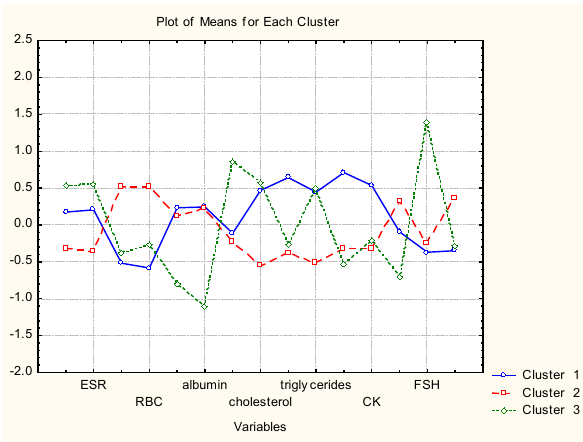
Figure 2: Plot of means of all clinical indicators for each cluster of